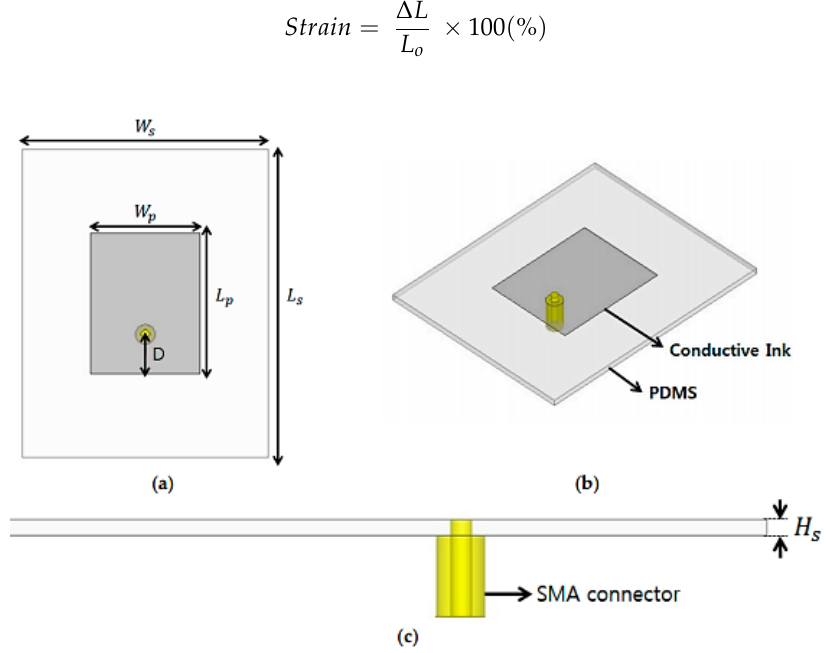
Figure 17. Dimensions of the addressed RF strain sensor: ( a ) top view; ( b ) perspective view; and ( c ) side view. W p = 17.05 mm, L p = 23.1 mm, W s = 40 mm, L s = 50.1 mm, D = 6.5 mm, and H s = 1.01 mm [78].